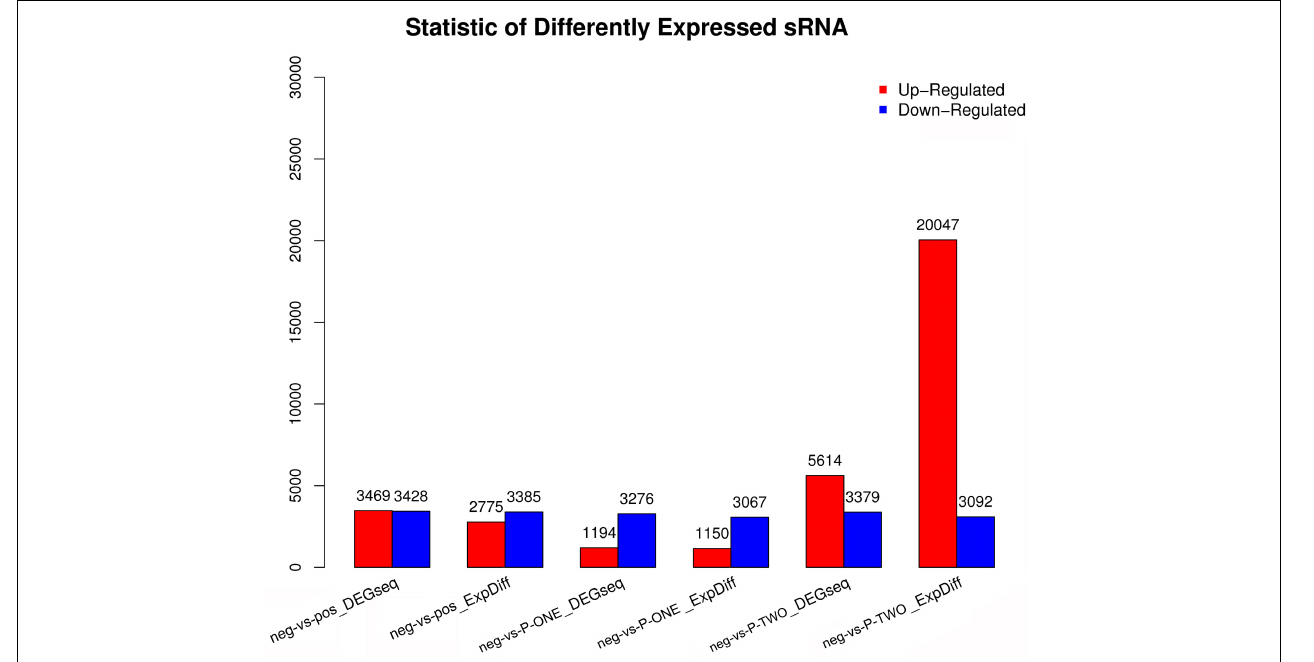
FIGURE 5 | Statistic of differential expressed sRNAs. Using DEGseq nad ExpDiff, we identified the differentially expressed piRNAs from four groups: 1) negative control group (neg); 2) positive control group (pos); 3) P-ONE group; 4) P-TWO group. X -axis represents pairwise and Y -axis means number of screened DESs. Blue bar denotes down-regulated and orange bar for the up-regulated. According to the figure, comparing to the control group, P-TWO have quite a large group of upregulated pi-RNAs, indicating that P-TWO may have specific pharmacological effects via microRNA regulation.